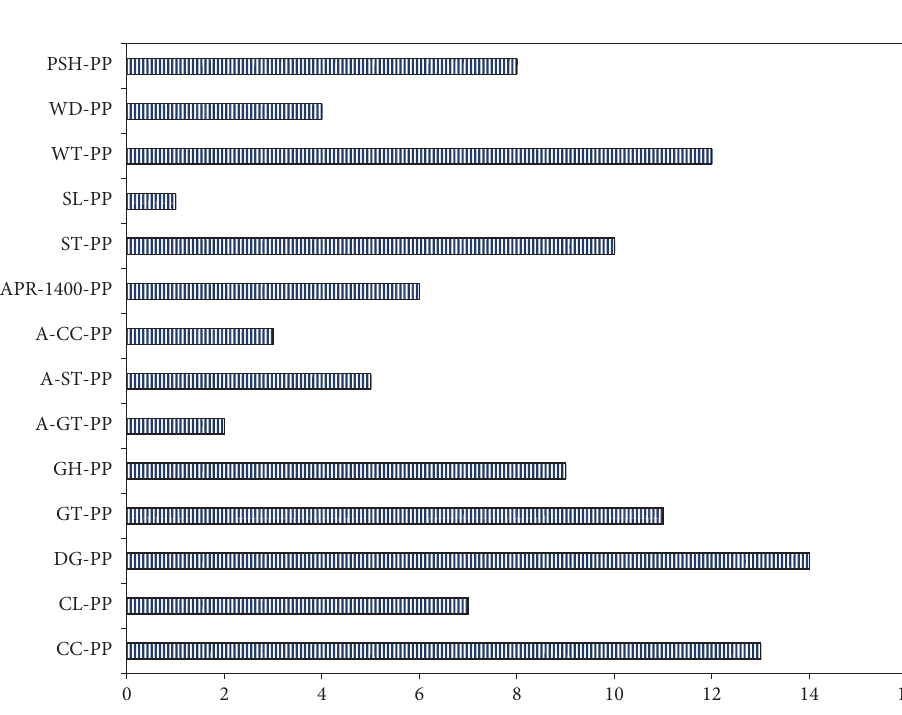
Figure 9: Ranking of power plant technologies by 2050 for Subscenario